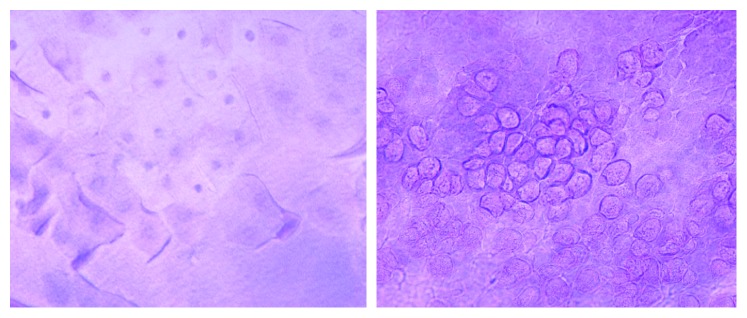
Observation of conjunctival cytogenes by an optical microscope. The goblet cells appear to be clustered and clotted in mucine clusters associated with the presence of metaplasic cellular specimens with some pyknotic nuclei.